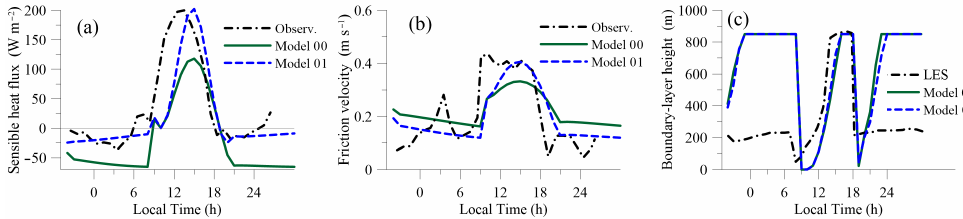
Figure 4. Comparison of single-cell results with observations data from [14]. ( a ) Sensible heat flux evolution. ( b ) Friction velocity evolution. ( c ) Boundary-layer height evolution compared with LES from [14].